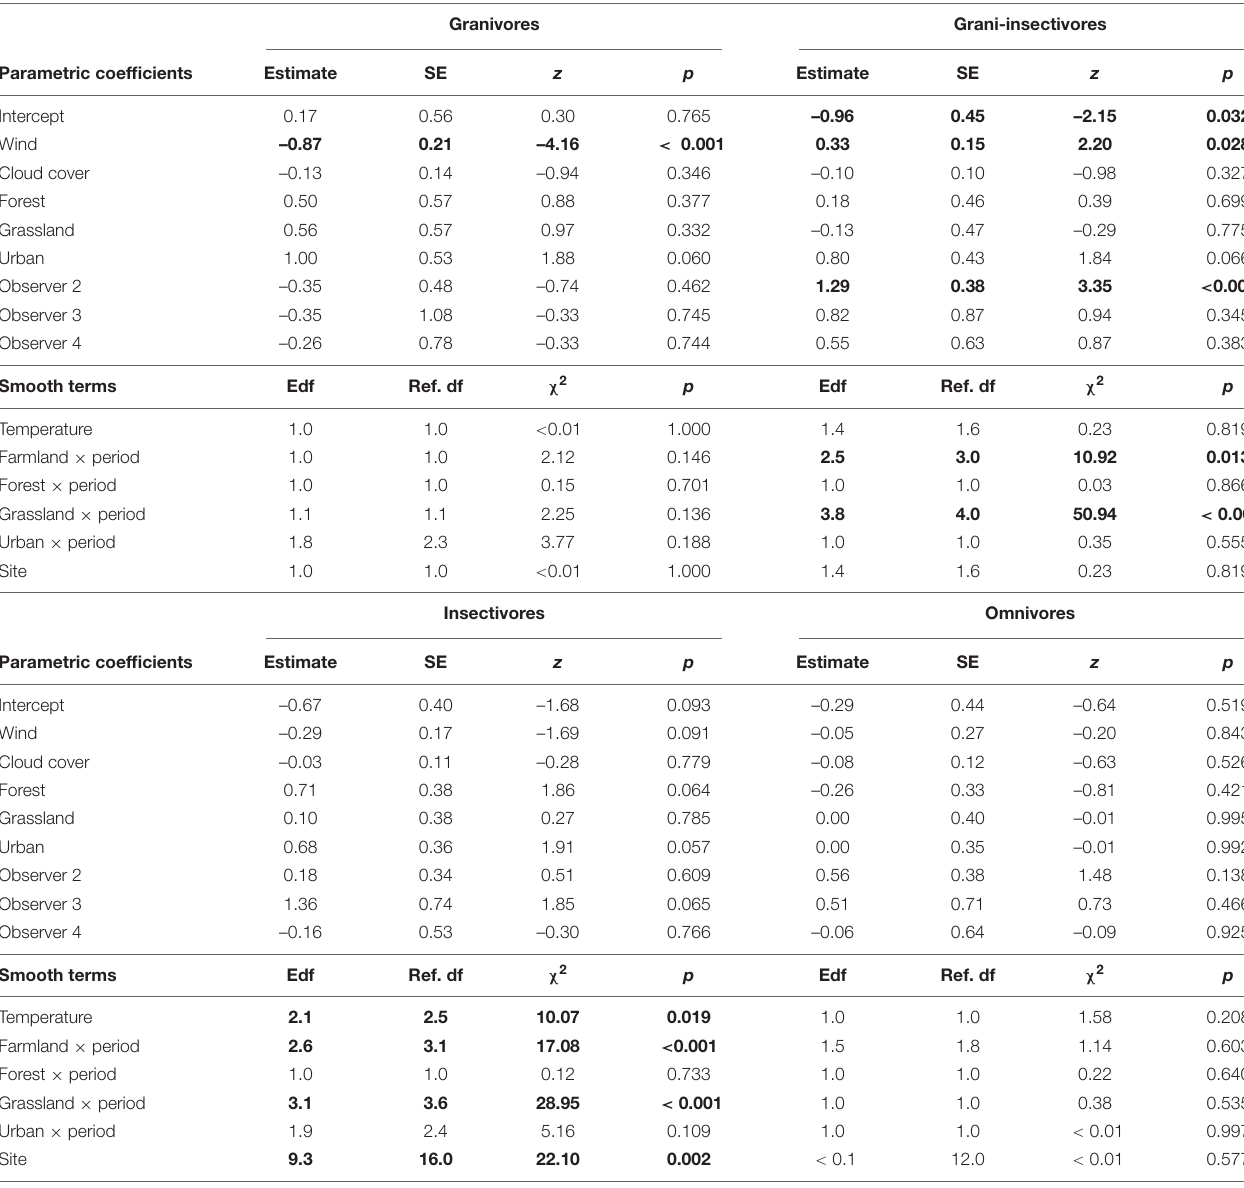
TABLE 2 | Coefficients and associated characteristics of GAMMs fitting detection rates of four bird trophic guilds (granivores, grani-insectivores, insectivores, and omnivores). Granivores